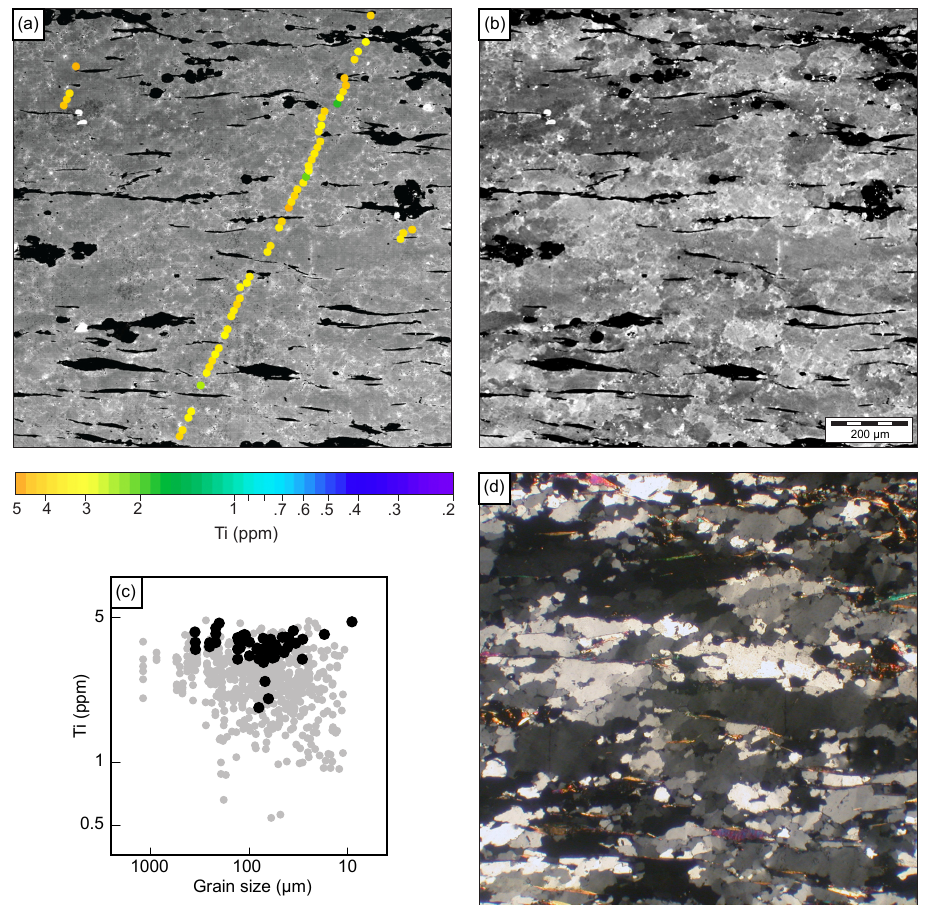
Figure 4. (a) Panchromatic (200–960nm) cathodoluminescence (CL) image of protomylonite metachert sample 77900 showing uniformity of Ti concentrations at analysis points. Panel (b) shows 470nm wavelength CL image. (c) Ti-in-quartz data for this sample (black) against a backdrop of data from other Gaunt Creek samples – no variation in Ti content with grain size is observed. (d) Cross-polarized photomicro- graph of the same area. As typical of many samples, Ti-in-quartz contents vary between ∼ 2 and 3ppm, with no apparent spatial pattern. The blue spectrum peak ( ∼ 470nm, 2.65eV) is dependent on quartz c -axis orientation, since dark grains in panel (b) are also dark in panel (d) . The Ti peak at ∼ 415nm (Wark and Spear, 2005) was not detected in this sample, probably due to the low concentrations of Ti in the sample.